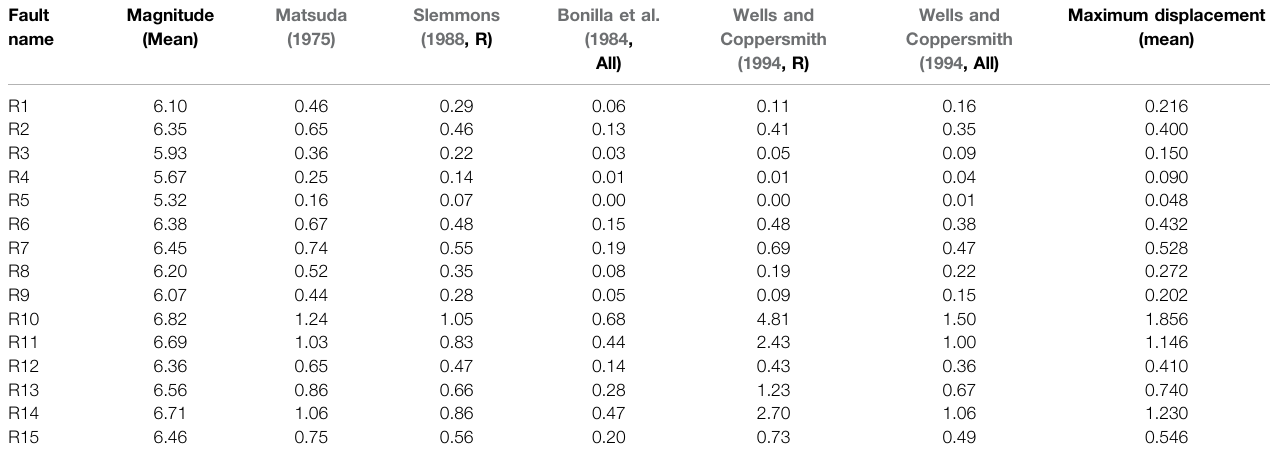
TABLE 3 | Estimation of the maximum displacement of the fault plane (m) calculated according to various combinations of empirical equations (R: reverse type only, All: reverse type + strike-slip type + normal type). Fault